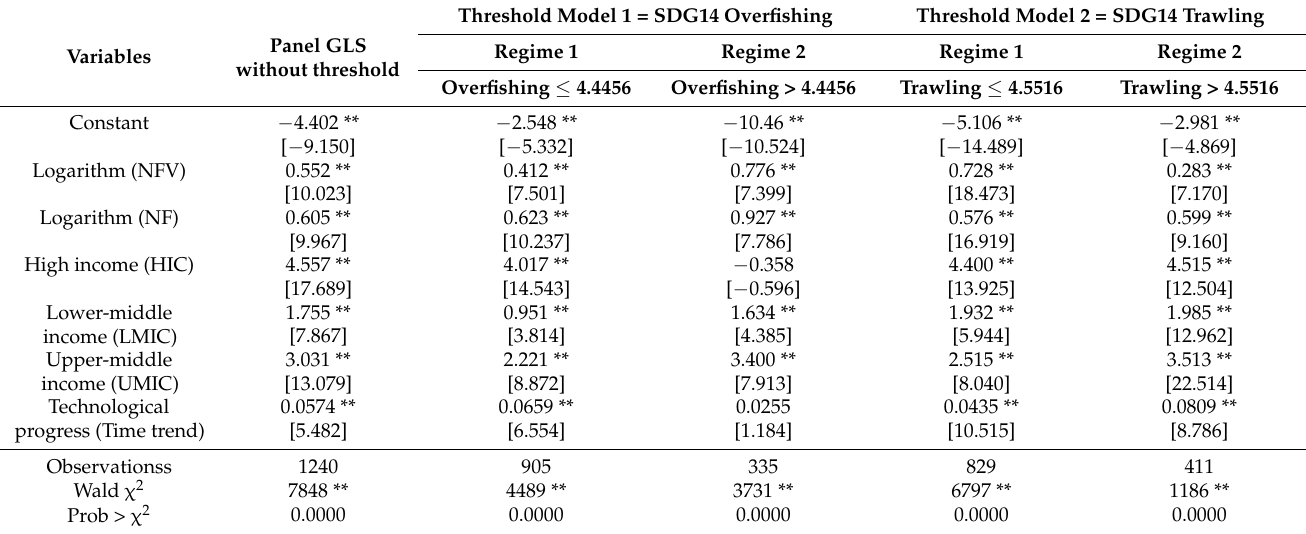
Table 5. Regression results using different threshold variables. Dependent variable: global fishery